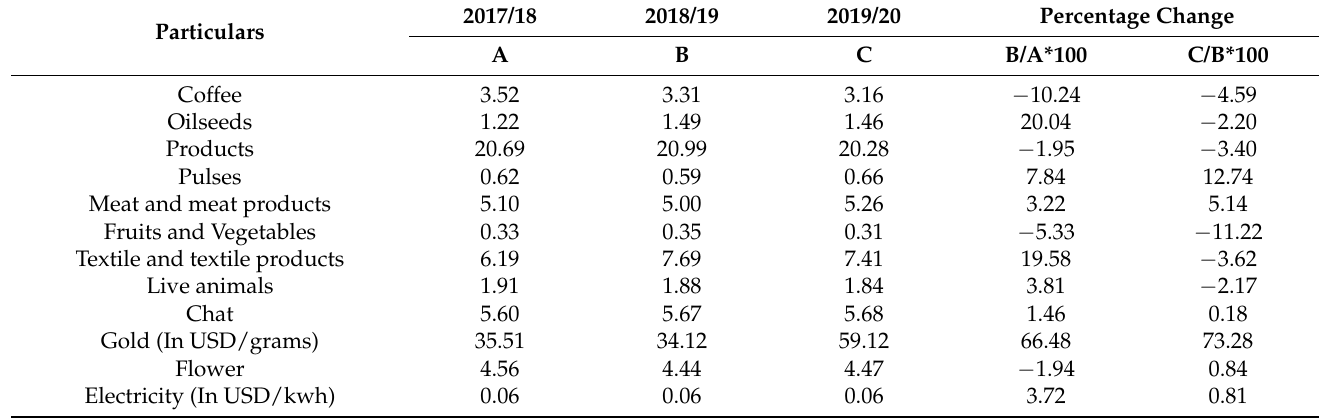
Table 1. Unit Value of Major Export Items. (In USD/kg unless stated